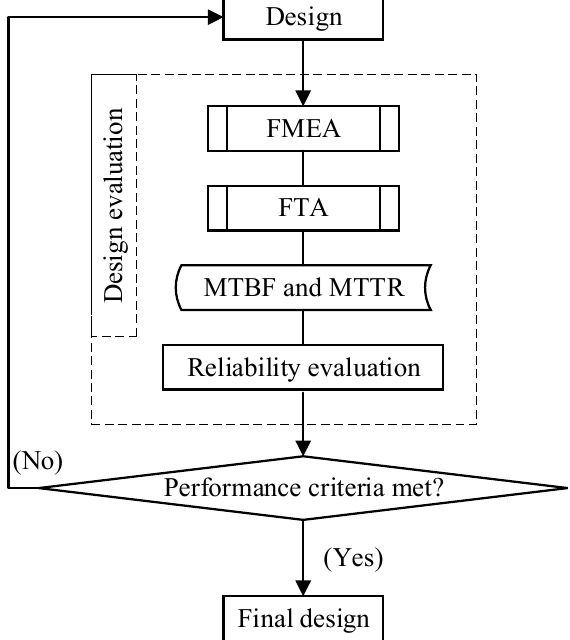
Figure 1. Design evaluation and reliability calculation process.